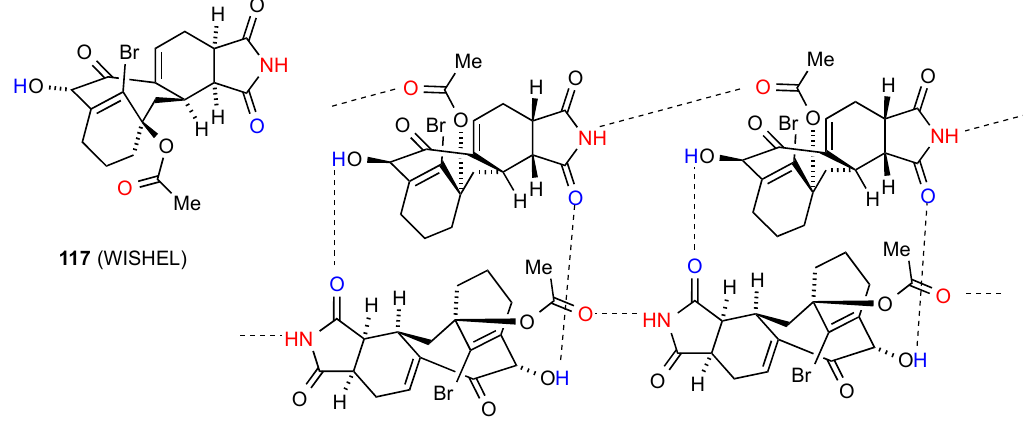
Figure 42. Structure adopted by compound 117.